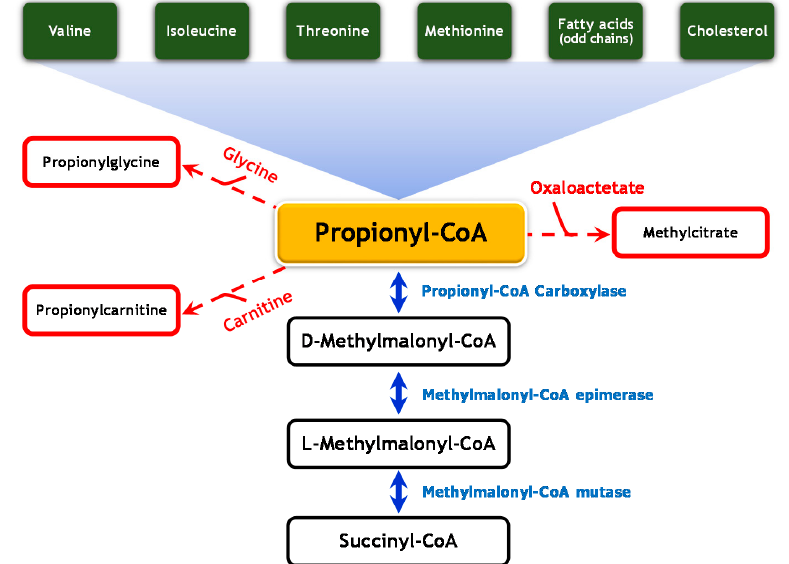
Figure 1. Metabolism of propionic acid. The catabolism of several amino acids (valine, isoleucine, threonine, and methionine) as well as odd chain fatty acids and cholesterol leads to the production of propionyl-CoA. When propionyl-CoA accumulates, other components—such as methylcitrate (formed by condensation of propionyl-CoA with oxaloacetate), propionylglycine, and propionylcarnitine—are found in urine and blood.